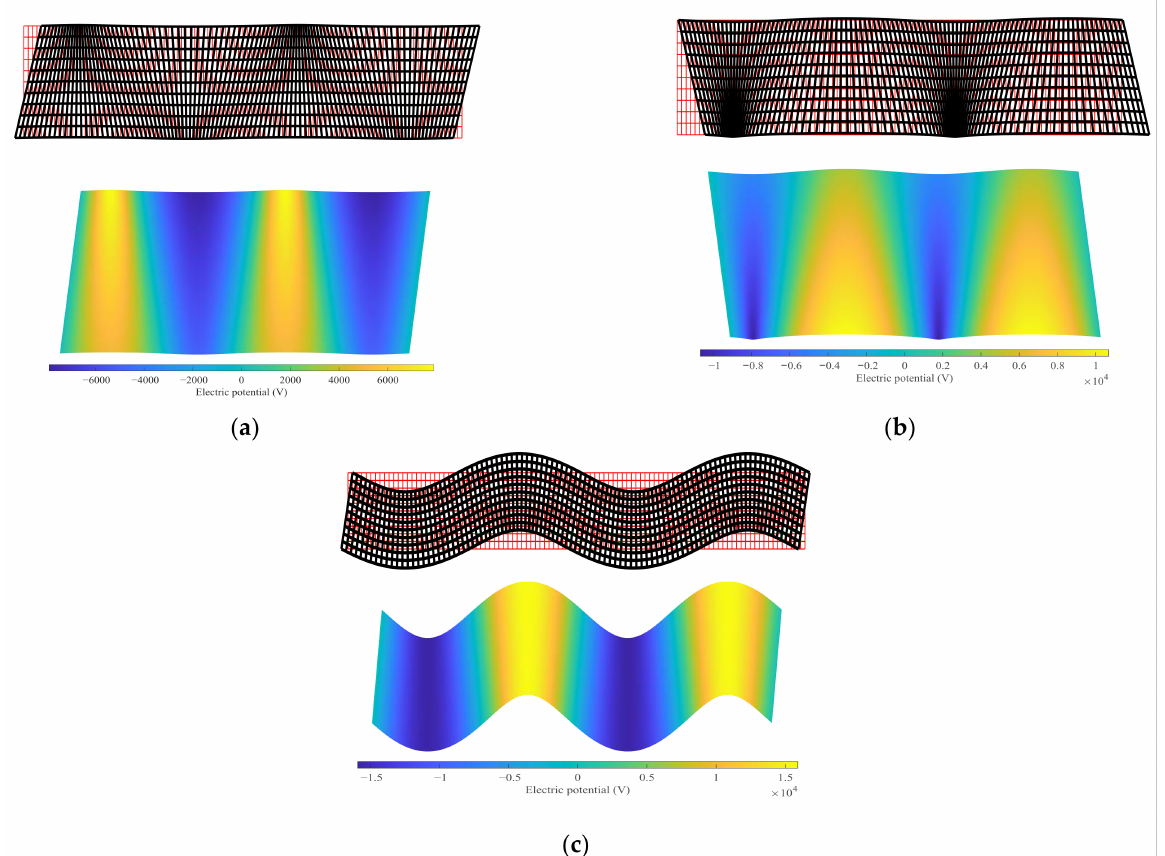
Figure 8. Distribution of the deformation and electric potential values of the ( a ) shear wave, ( b ) ex- tensional wave, and ( c ) flexural